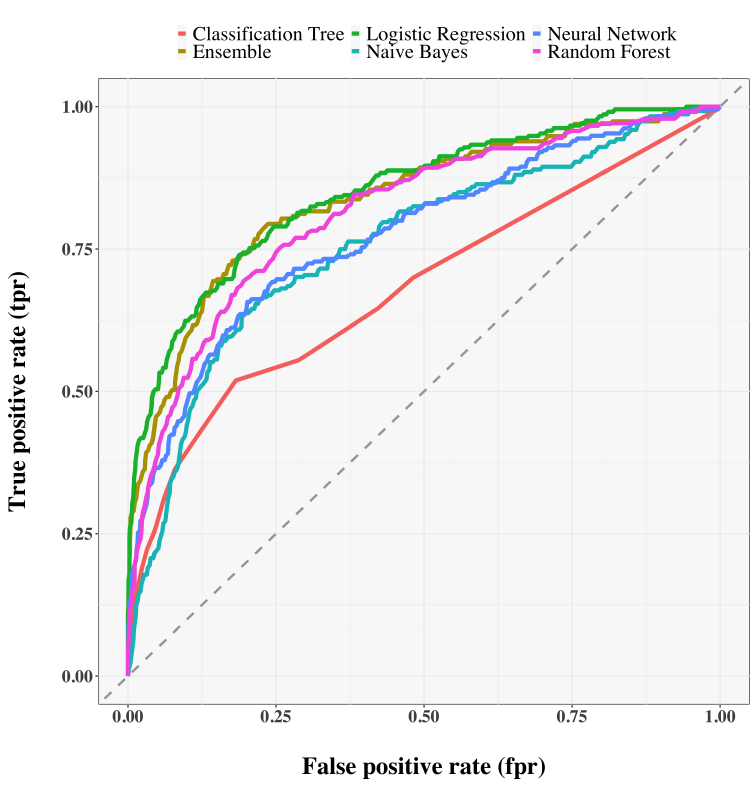
Figure 4. Barplots and ROC curves for the selected models on test